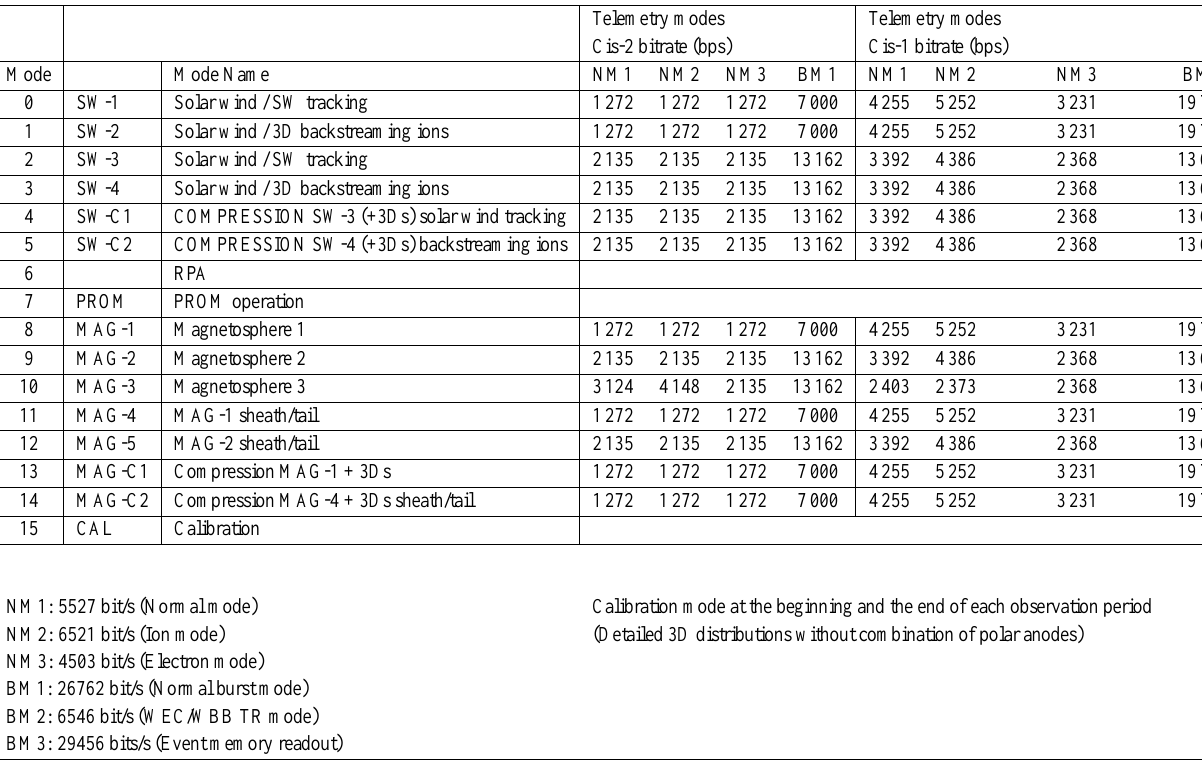
Table 7. Cluster-2 CIS operations